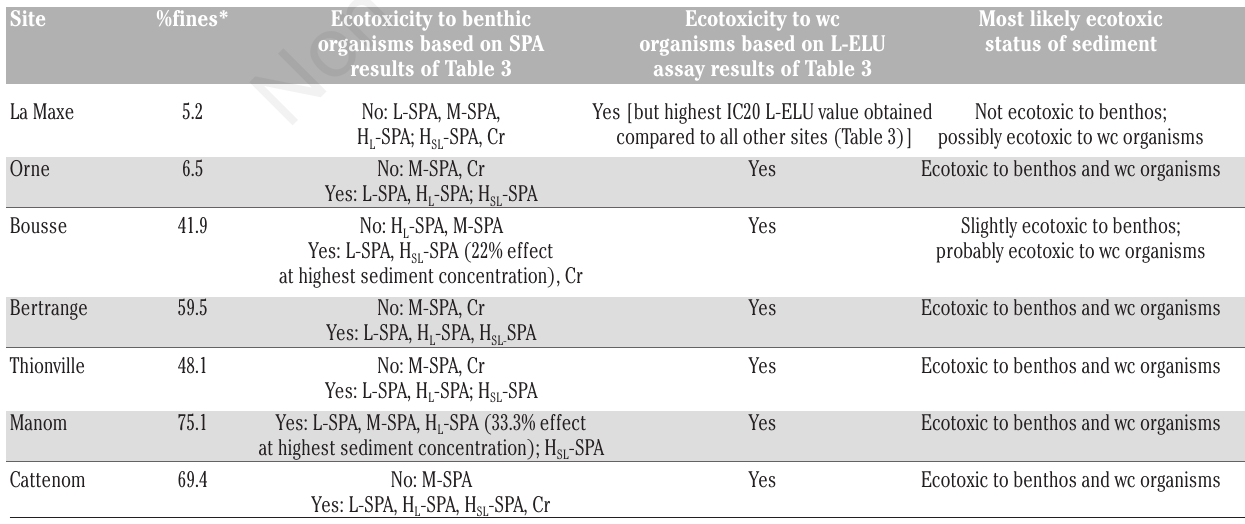
Table 4. Ecotoxic status of Moselle river watershed sediments according to solid phase and LuminoTox elutriate test results of Table 3, as well as on sediment ecotoxicity criteria based on grain size considerations.